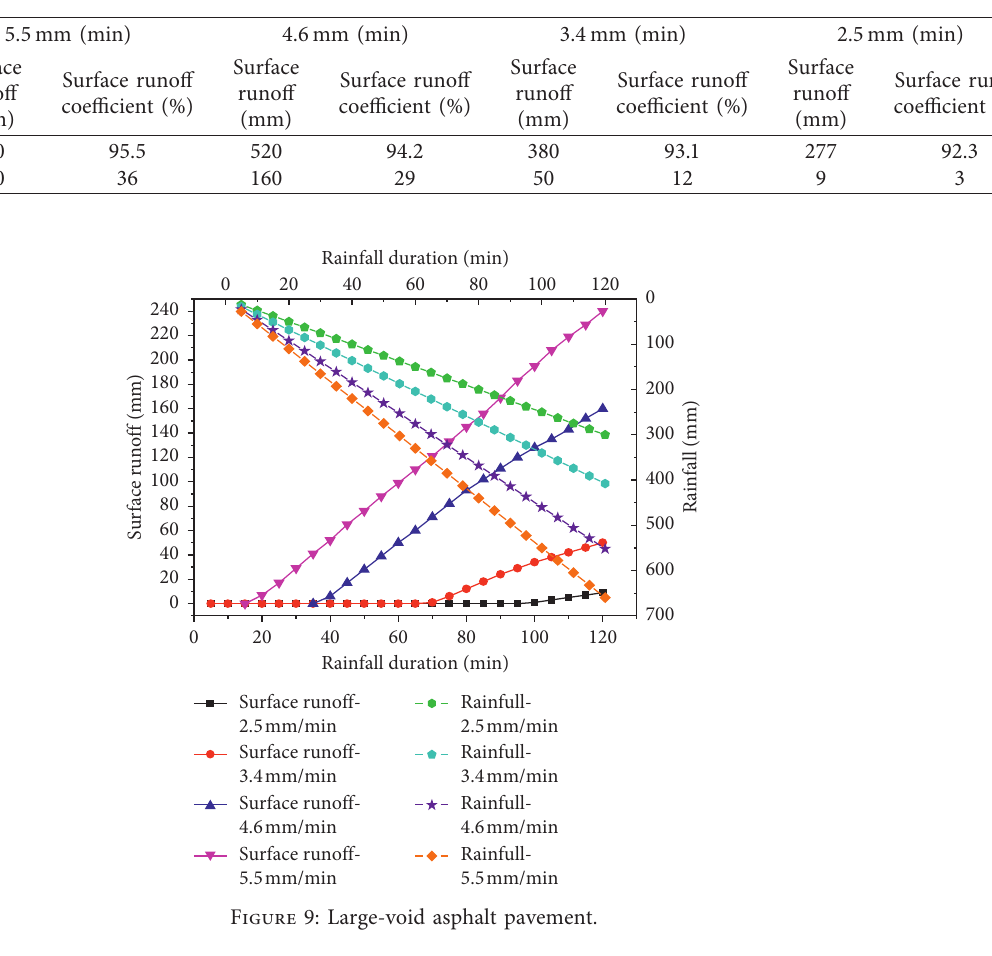
Table 3: Surface runoff coefficients at different rainfall intensities.